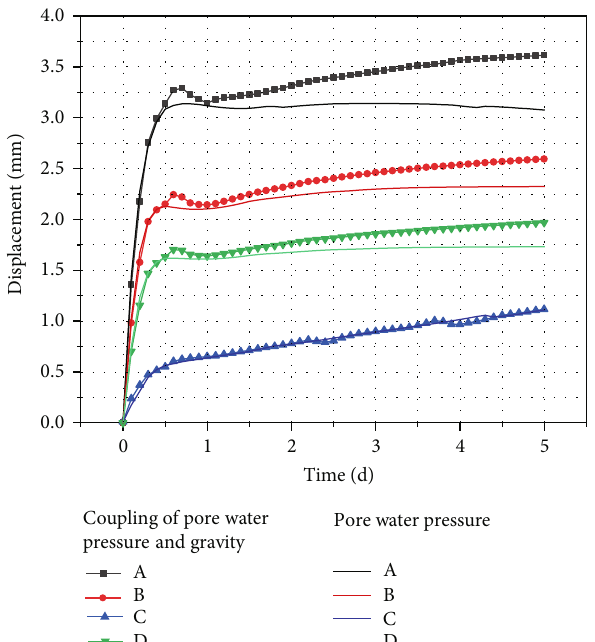
Figure 10: Comparison of displacement at each monitoring point varying with rainfall time in two cases.